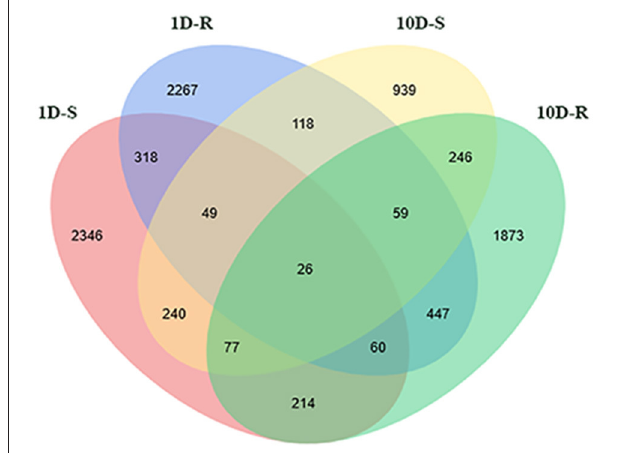
FIGURE 2 | Venn diagram of DEG statistics. The labels of 1D-S, 1D-R, 10D-S, and 10D-R mean the DEGs form -P-1D-S vs. CP-1D-S, -P-1D-R vs. CP-1D-R, -P-10D-S vs. CP-10D-S, and -P-10D-R vs. CP-10D-R,